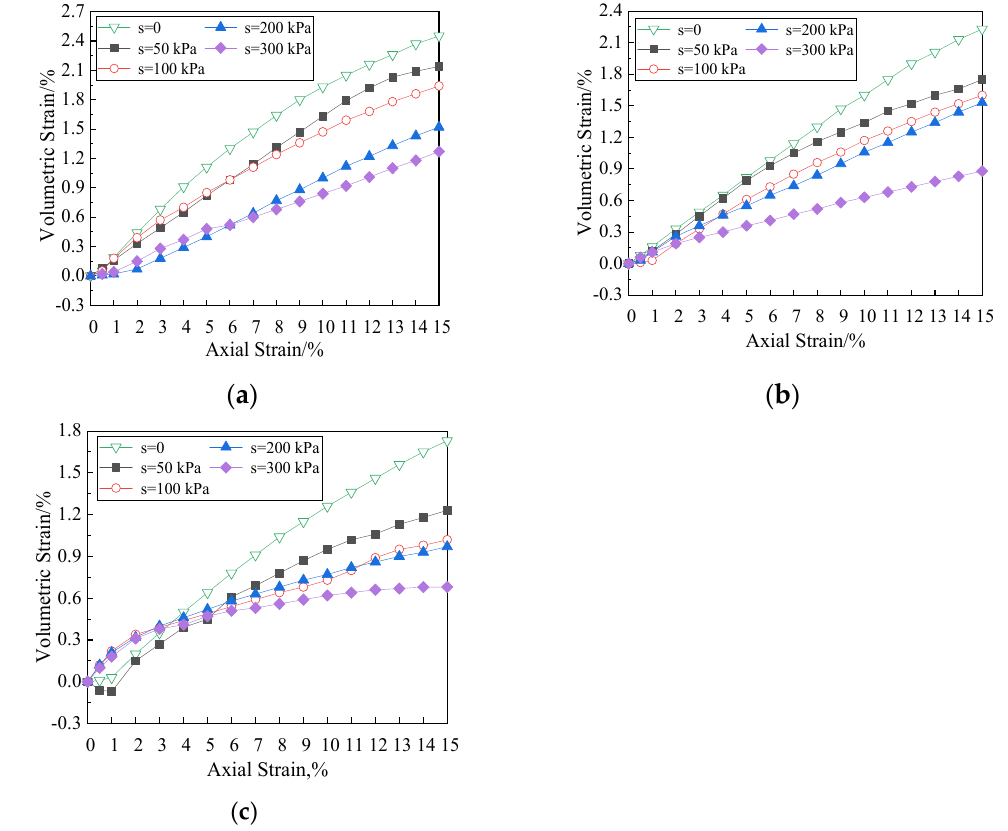
Figure 11. Effects of matric suction on volumetric strain vs. axial strain curves (Fiber length = 12 mm). ( a ) Net confining pressure = 50 kPa, ( b ) net confining pressure = 100 kPa, ( c ) net confining pressure = 200 kPa.